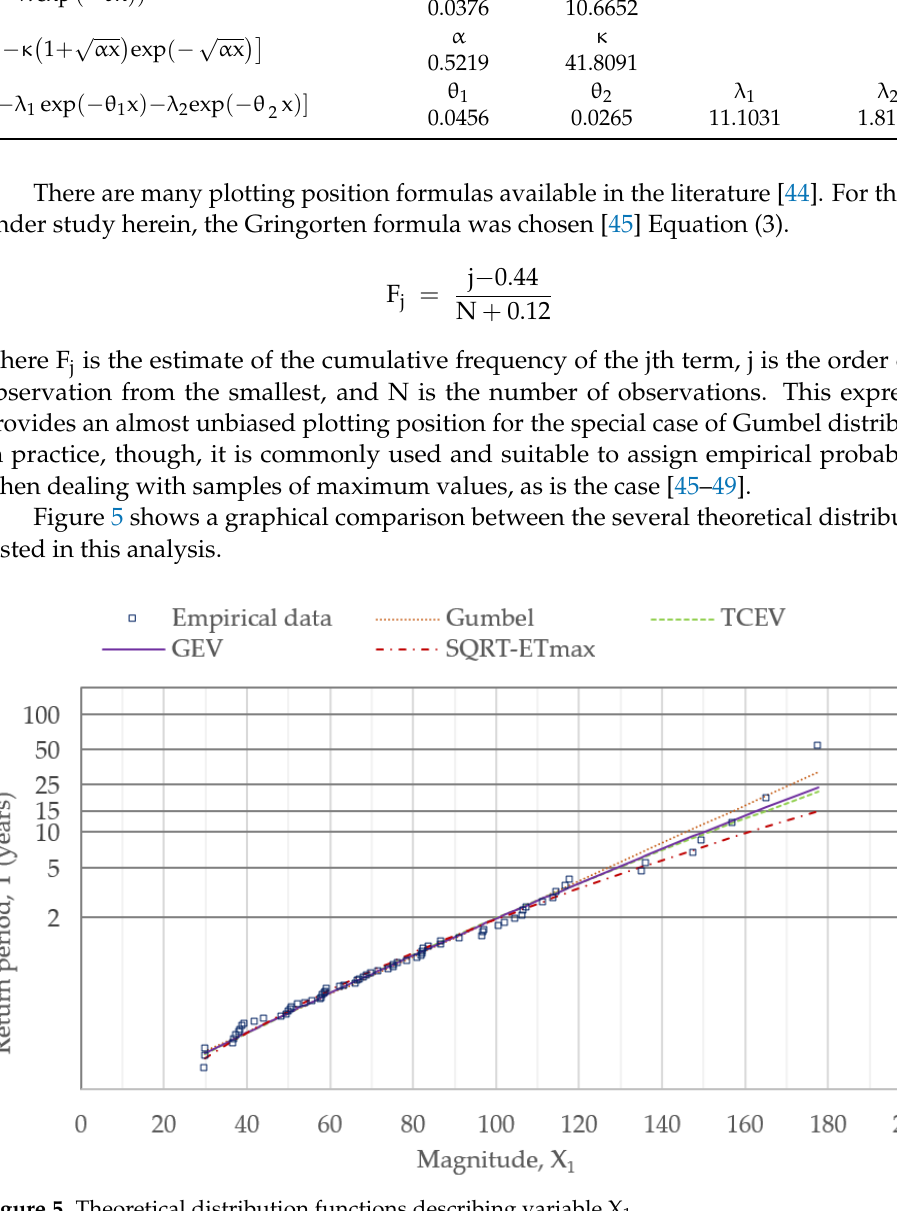
Table 4. Goodness-of-fit test statistics.